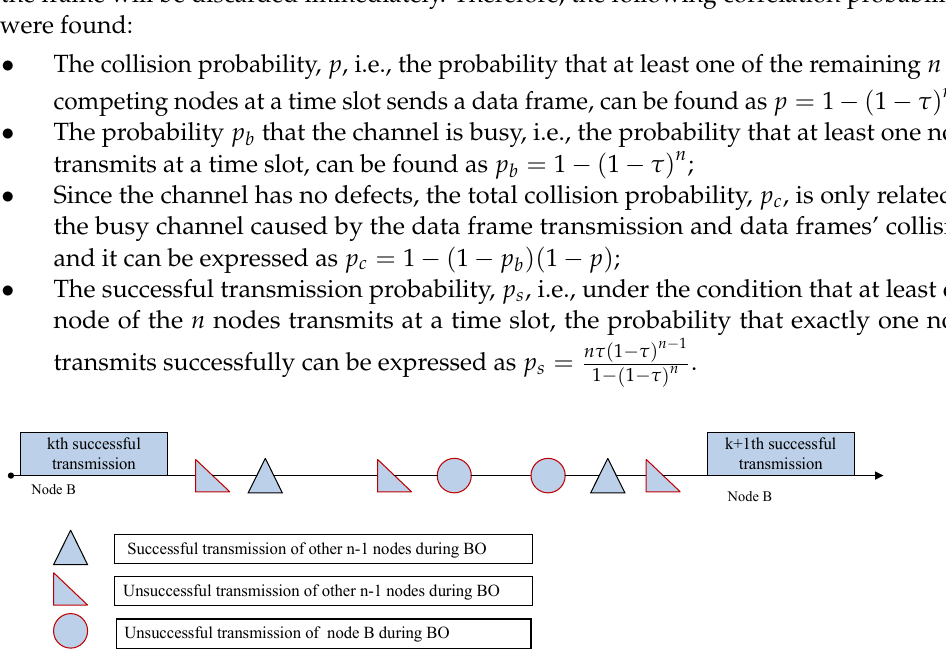
Figure 3. Possible events that occurred between two consecutive successful transmissions for node